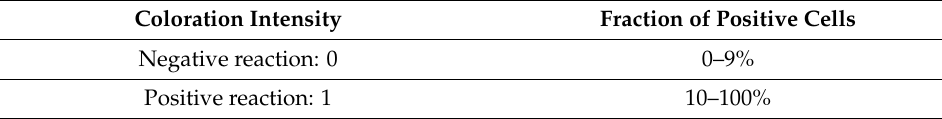
Table 6. Semi-quantitative evaluation of